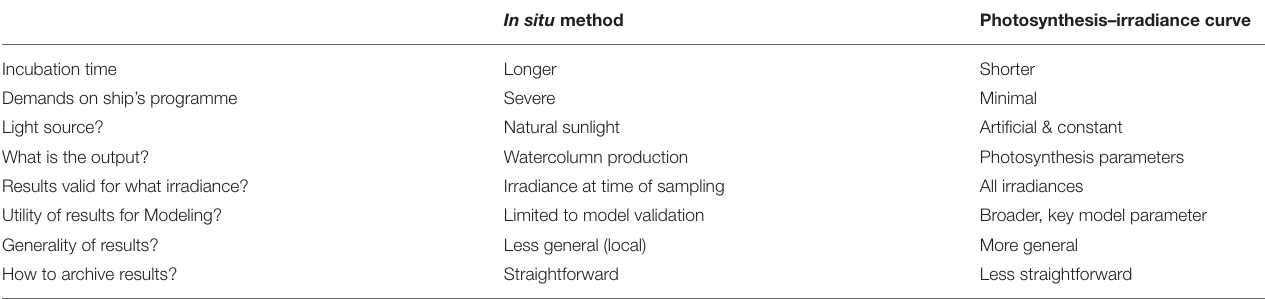
TABLE 1 | Comparison of two approaches ( in situ method and photosynthesis-irradiance curve) to measuring primary production of aquatic